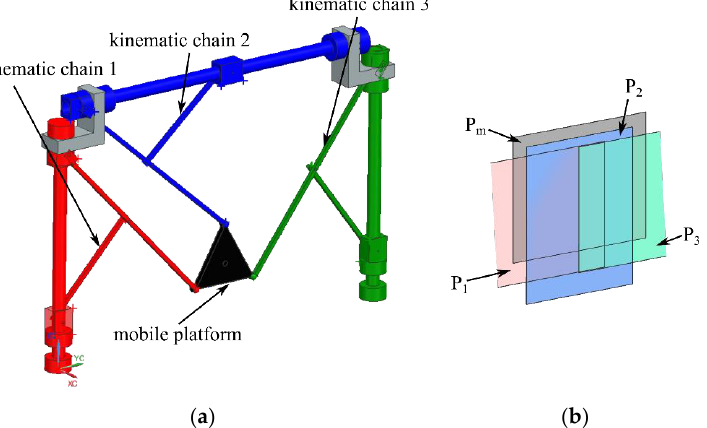
Figure 13. Type II singularity of the 6-DOF parallel robot for SILS (case 8 — all the faces and the base of the characteristic tetrahedron are coplanar): ( a ) parallel robot pose; ( b ) characteristic planes.